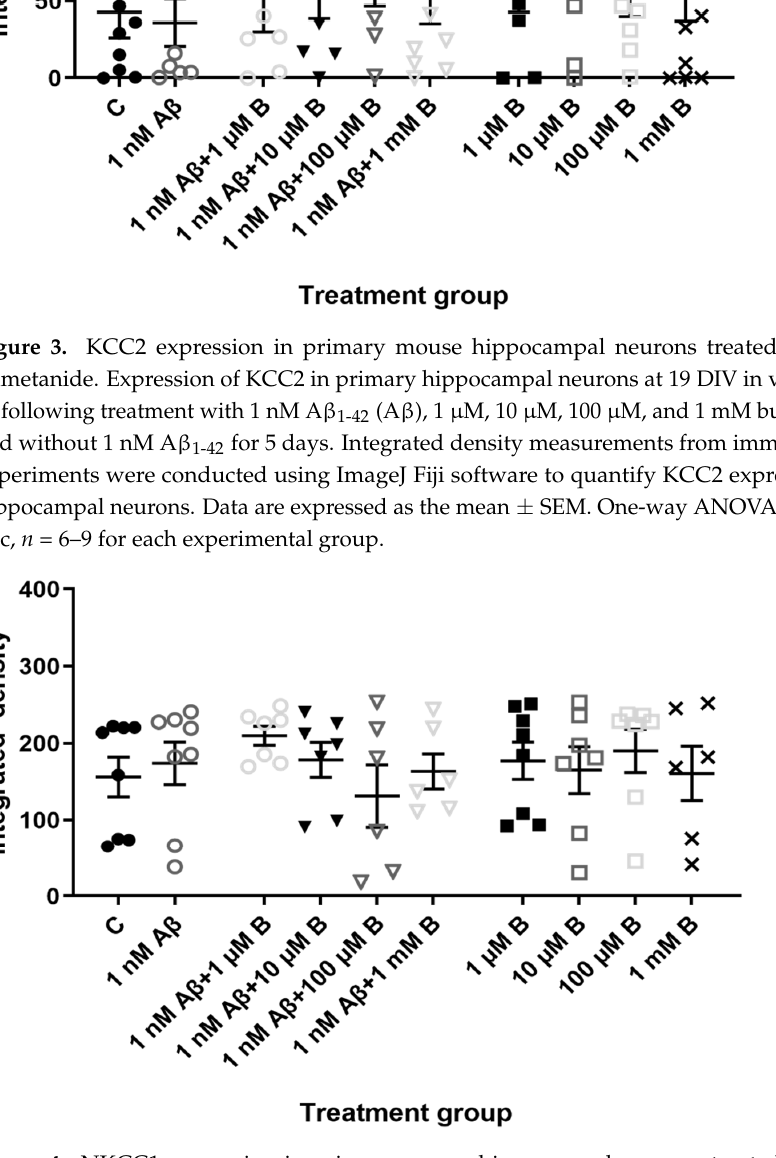
Figure 4. NKCC1 expression in primary mouse hippocampal neurons treated with A β 1-42 and bumetanide. Expression of NKCC1 in primary hippocampal neurons at 19 DIV in vehicle controls (C) or following treatment with 1 nM A β 1-42 (A β ), 1 µ M, 10 µ M, 100 µ M, and 1 mM bumetanide (B) with and without 1 nM A β 1-42 for 5 days. Integrated density measurements from immunocytochemistry experiments were conducted using ImageJ Fiji software to quantify NKCC1 expression on primary hippocampal neurons. Data are expressed as the mean ± SEM. One-way ANOVA with Tukey’s post hoc, n = 6–8 for each experimental